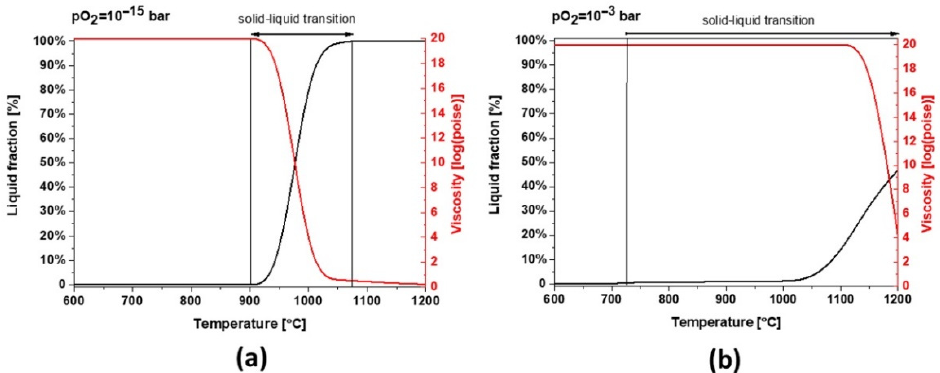
Figure 9. Thermodynamic modeling of liquid fraction and viscosity for slag 1 ( a ) pO 2 = 1 × 10 − 15 bar and ( b ) pO 2 = 1 × 10 − 3 bar.